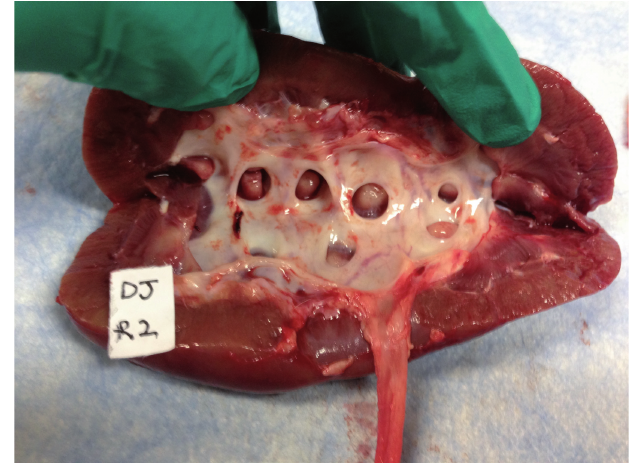
figure 2 - Representative image after double-pigtail stent dye